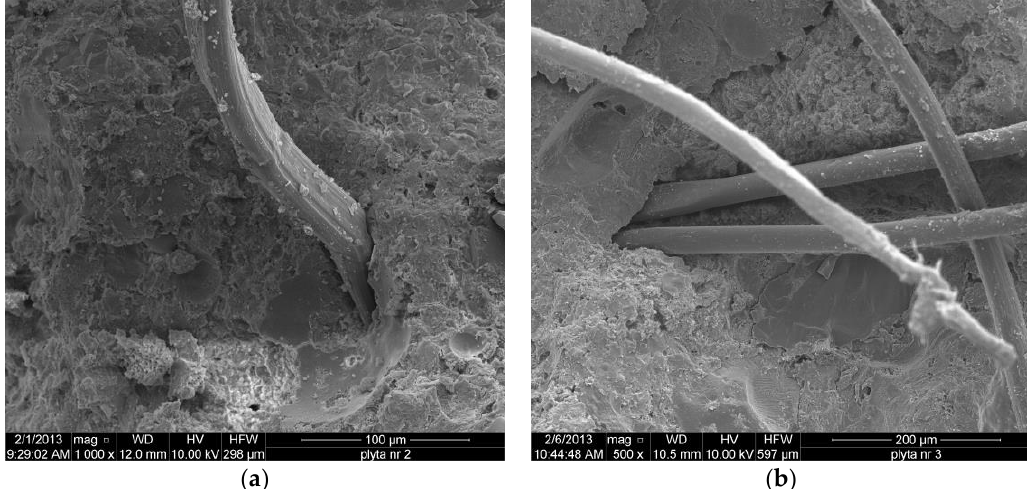
Figure 8. Scanning electron microscope images of polypropylene (PP) fibre in slab ( a ) S2; ( b ) S3.